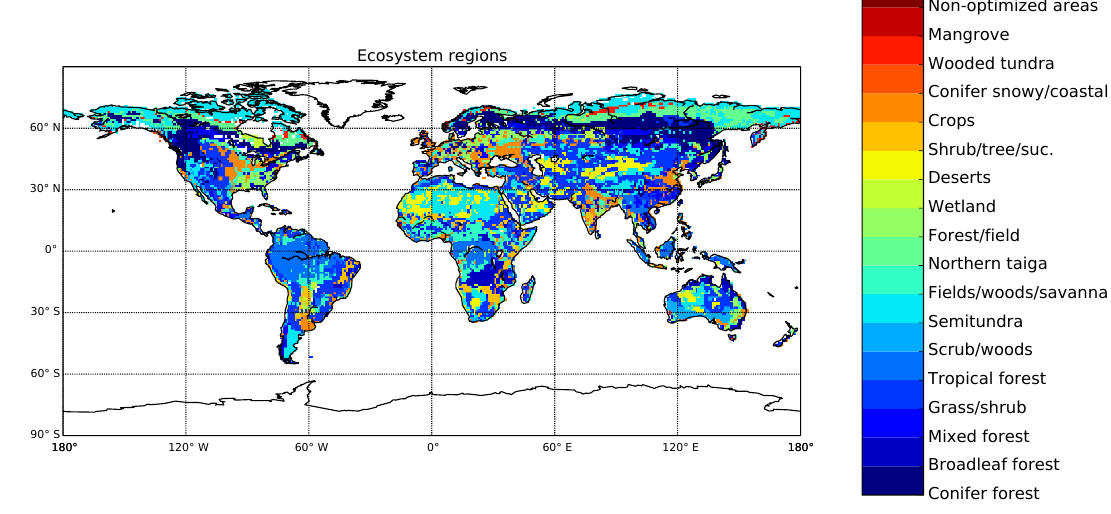
Figure 1. Global distribution of Olson ecosystem types.